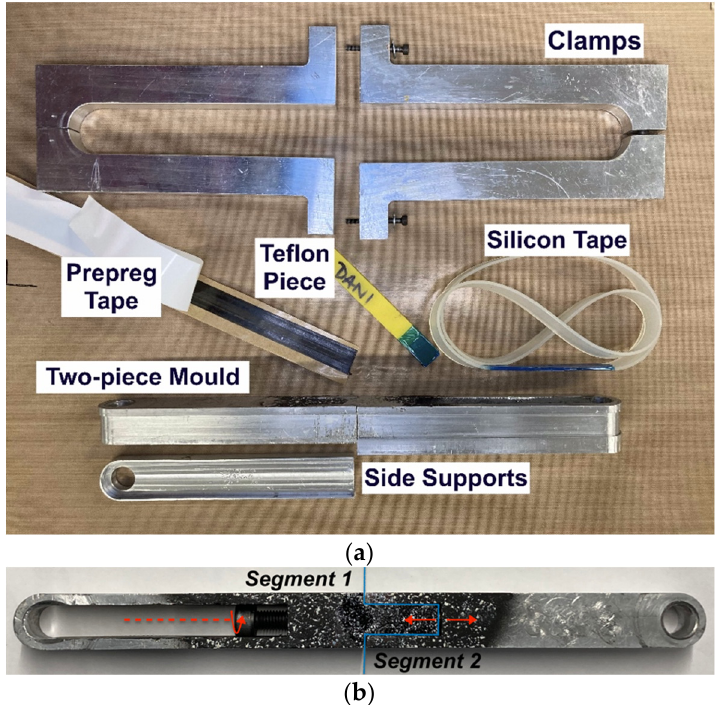
Figure 10. Pretensioning mold: ( a ) Parts used in manufacturing; ( b ) side view of two-piece mold.